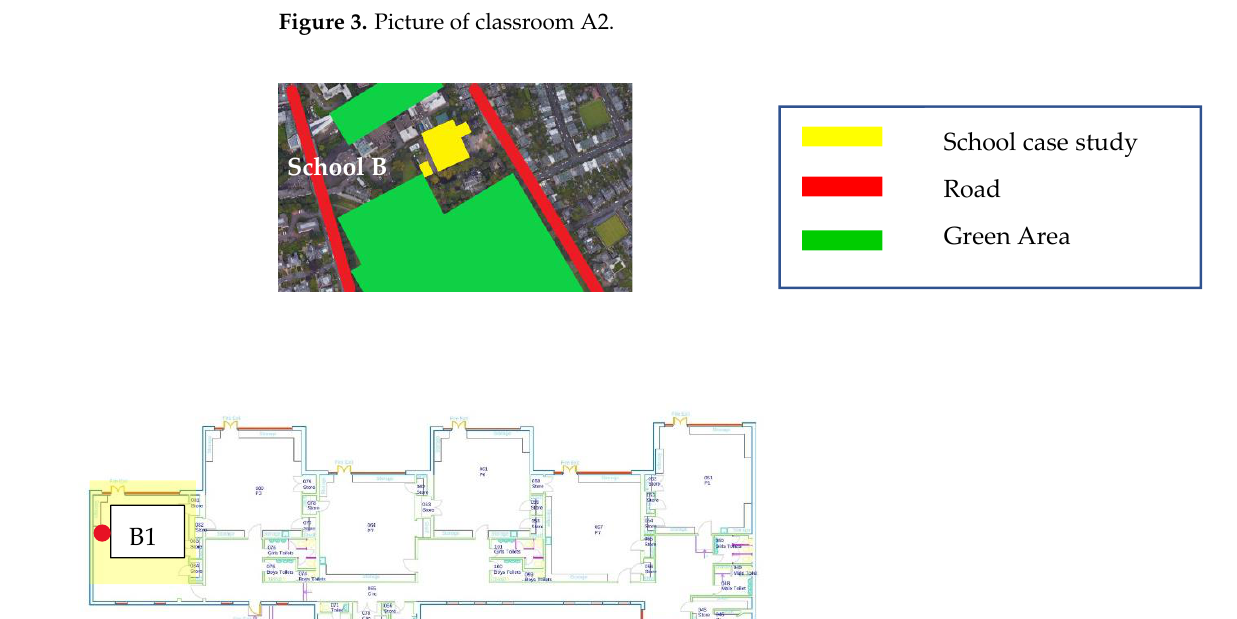
Figure 3. Picture of classroom A2.